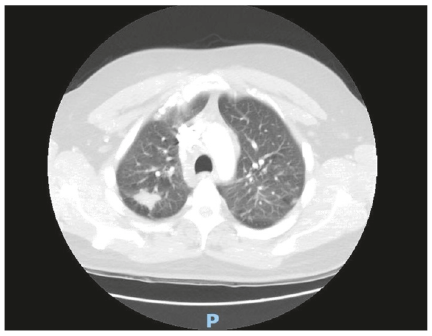
Figure 4: CT lung depicting right upper lobe lung nodule (Case 1).